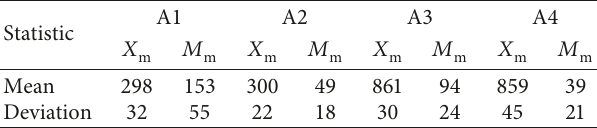
Table 5: Mean and standard deviation of marginal